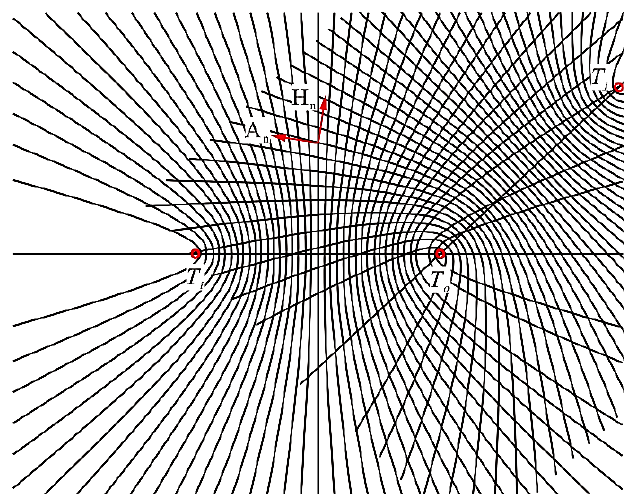
Figure 4. Crossed hyperbolic domain. The residual variation rate in the axial and horizontal direction, A n and H n , can be improved by adjustment of the sensors T i , T j , and T 0 .